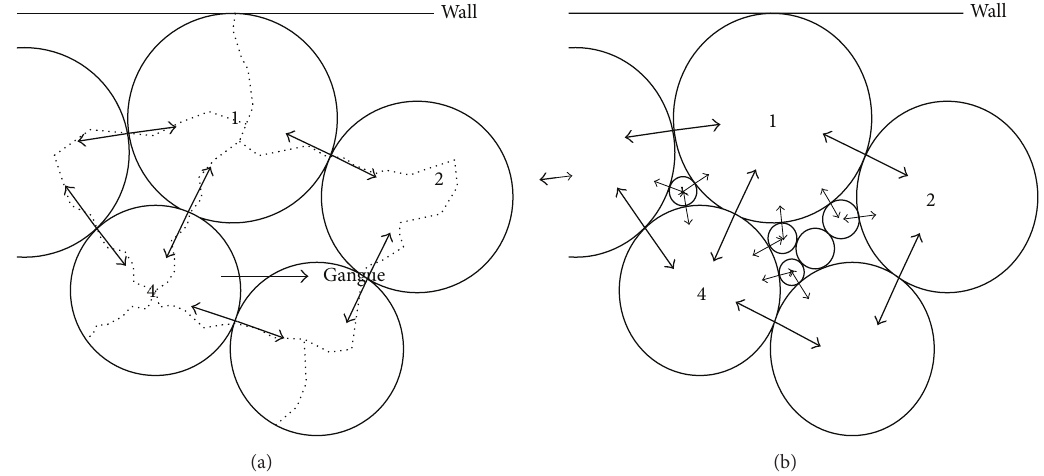
Figure 9: Stress schematics of spoil samples with (a) single gradation and (b) Talbot’s